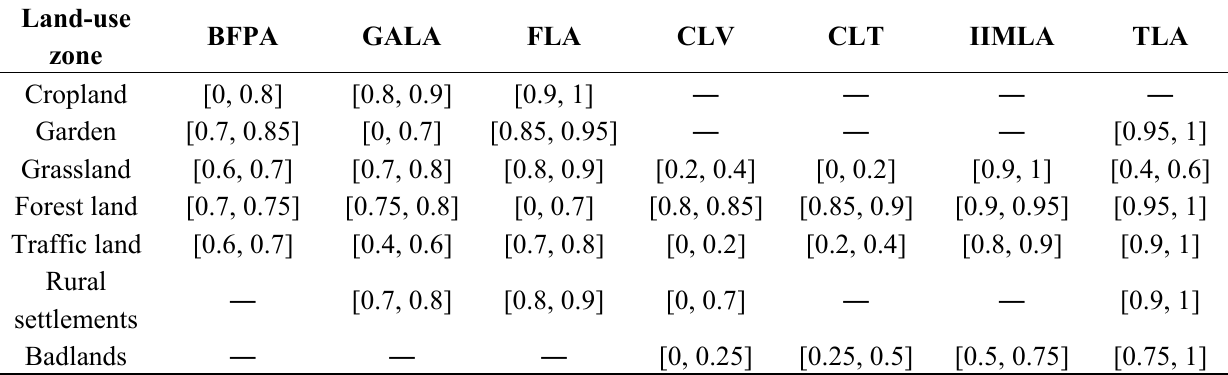
Table 6. The probability intervals of certain land-use types being allocated to certain land-use zone